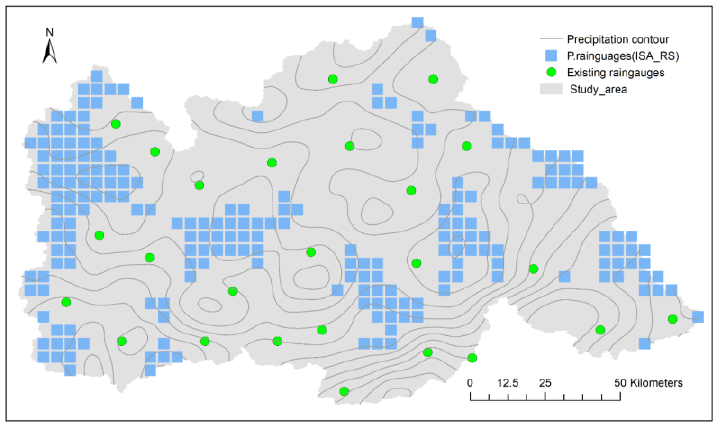
Figure 9. Distribution of the potential positions of the 26th rain gauge.